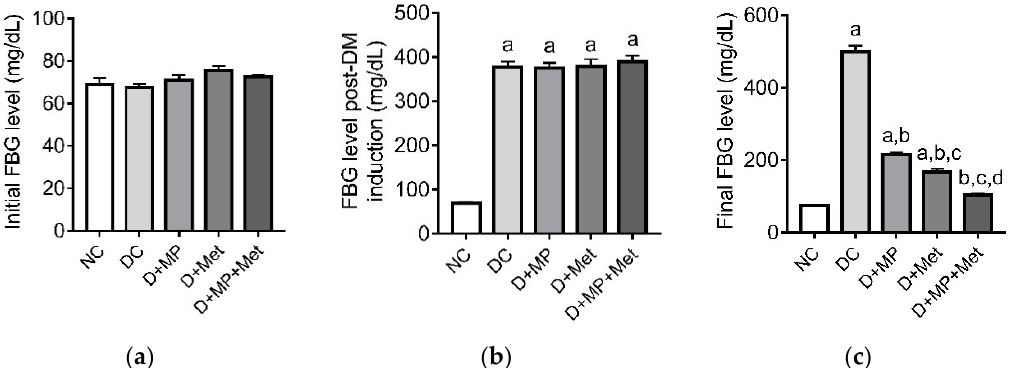
Figure 1. Initial fasting blood glucose level ( a ), fasting blood glucose level post ‐ diabetes induction ( b ) and final fasting blood glucose level ( c ). Values are means ± SDs, n = 8. a p < 0.05 versus NC, b p < 0.05 versus DC, c p < 0.05 versus D+MP, d p < 0.05 versus D+Met (one ‐ way ANOVA followed by Tukey’s